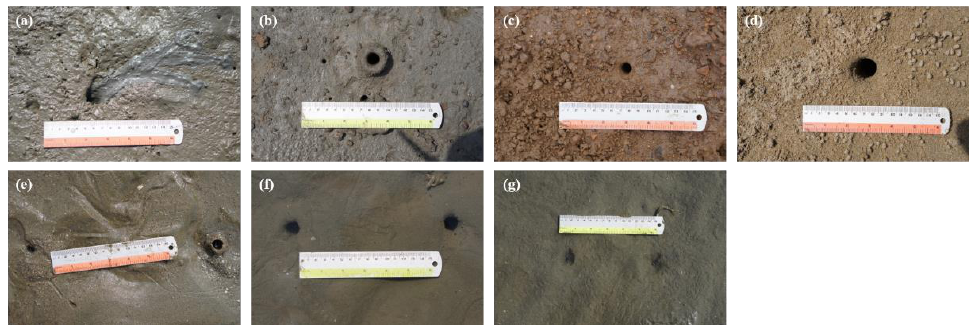
Figure 2. The burrow morphologies of six macroinvertebrates species. ( a ) M. japonicus , ( b ) U. arcuata , ( c ) U. lactea lactea , ( d ) O. stimpsoni , ( e ) U. unicinctus , ( f ) normal openings, and ( g ) abnormal openings for U. major .